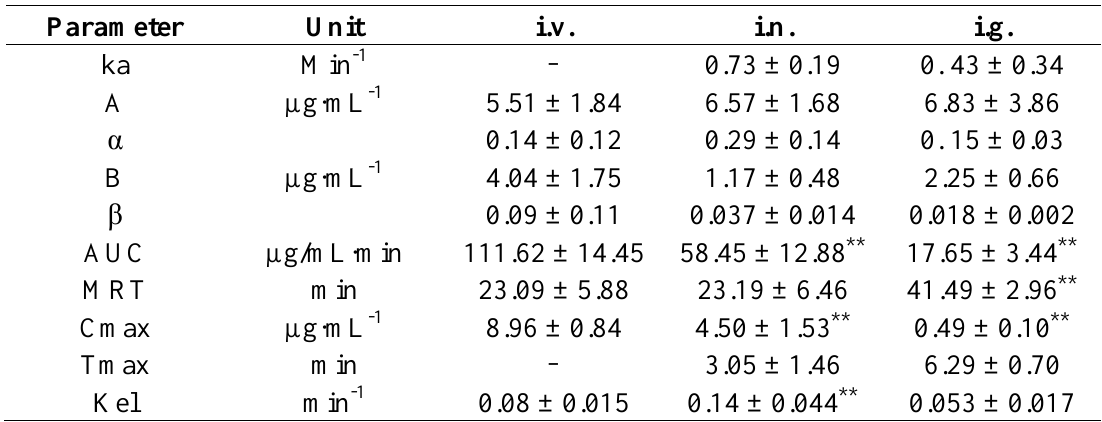
Table 5. Main pharmacokinetic parameters of plasma after i.v. and i.n. and i.g. administration of paeonol in rats ( n = 5, mean ±